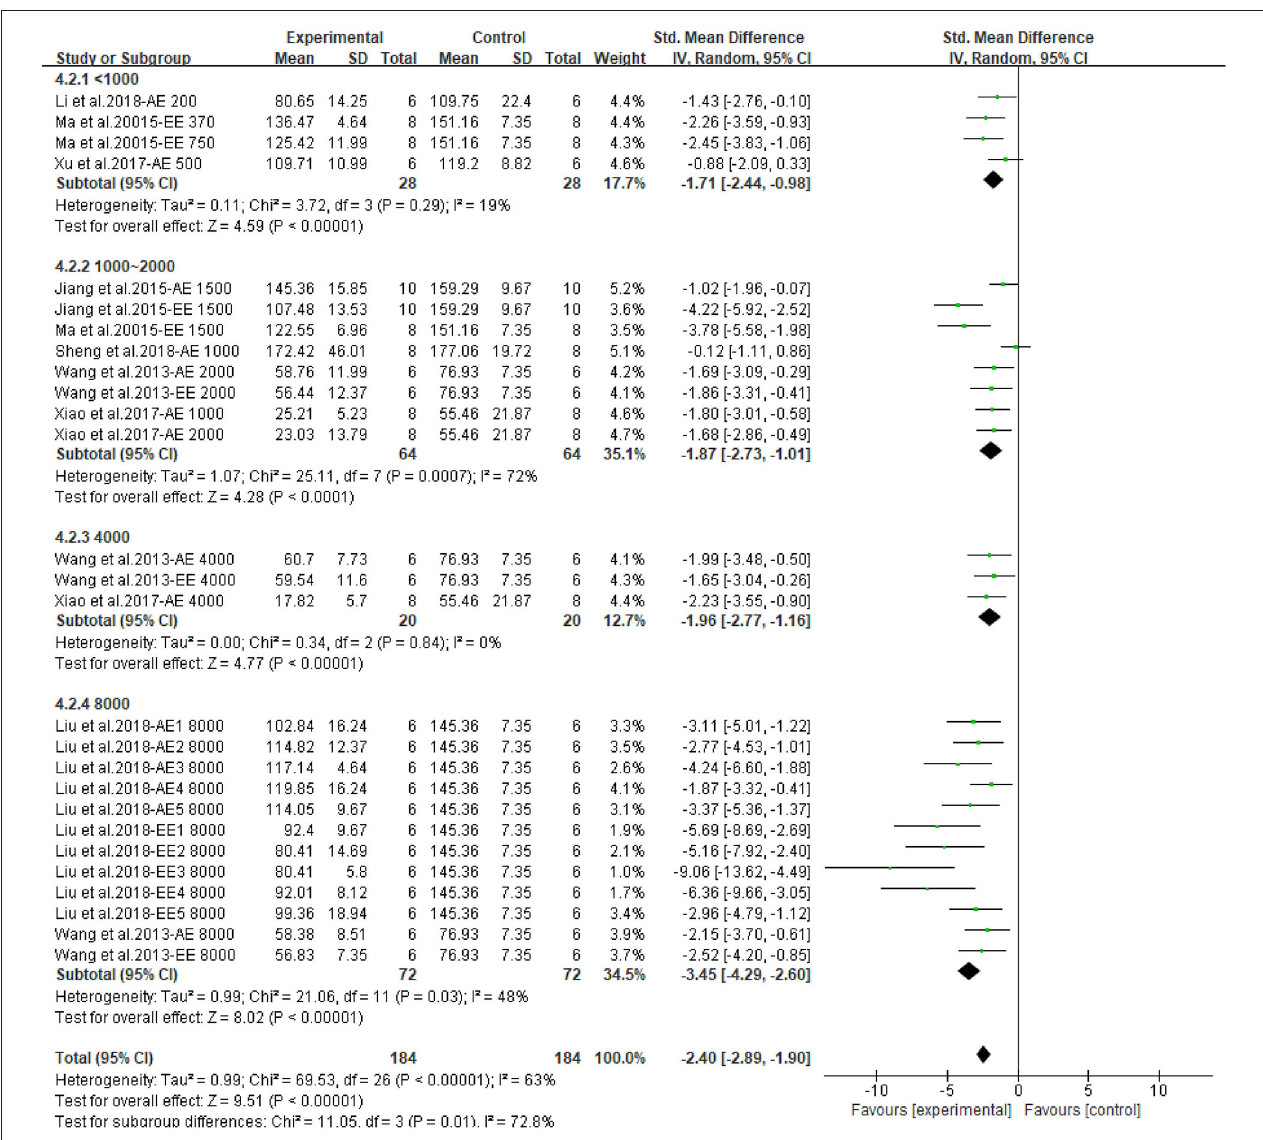
FIGURE 6 | Forest plot for the effect of Cyclocarya paliurus (CP) on total cholesterol levels in animal models. Subgroup analysis was performed according to doses.